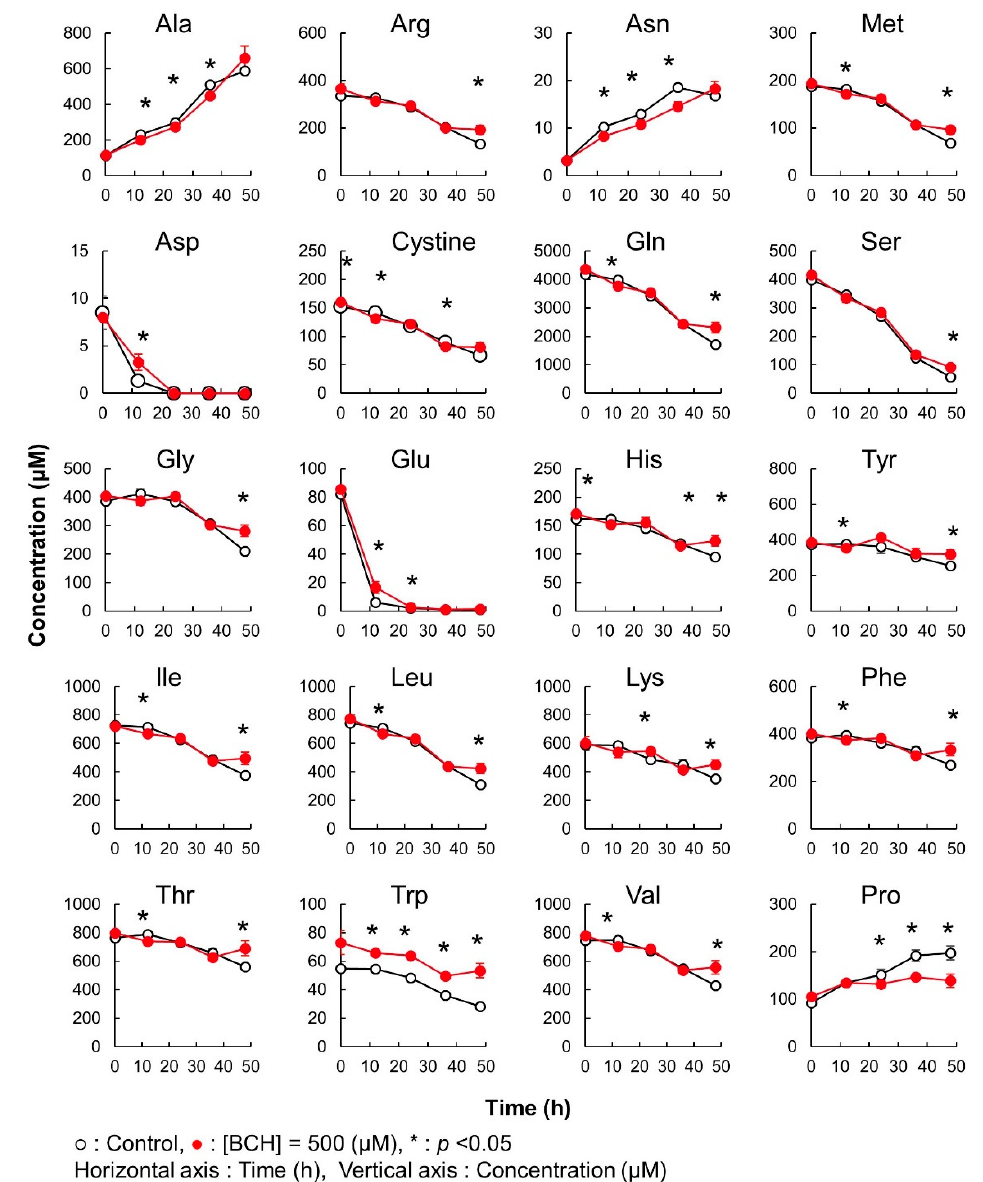
Figure 6. Method validation of iPDAQ: time course of the amino acid concentration in the medium used for the cultivation of HeLa cells. Each graph represents the time course of the amino acid concentration. Close and open circles indicate the results with (BCH addition) and without (Control) the amino acid inhibitor. Error bars indicate the standard deviation ( n = 3).